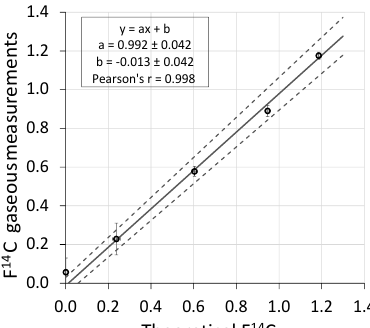
Figure 2. F 14 C values of synthetic and standard (test) aerosol sam- ples measured with the gas source compared with theoretical values. These test aerosols are made of two Standard Reference Materials (SRM 2975 and SRM 1515). The compositions of the different mix- tures are listed in Table 1 with the corresponding theoretical and measured F 14 C. The coefficients of the linear regression have been calculated by taking into account error bars (2SD) on both axes and are given with their 95% confidence interval. The linear rela- tion confirms the accuracy of aerosol measurements with the gas ion source over the full range of expected 14 C